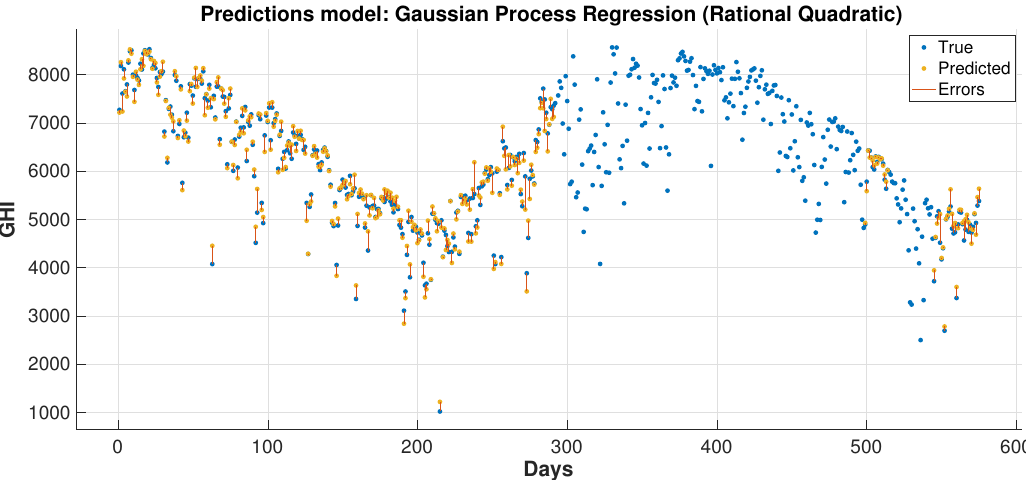
Figure 13. The predicted solar irradiance versus the real values for QU dataset with reduction.